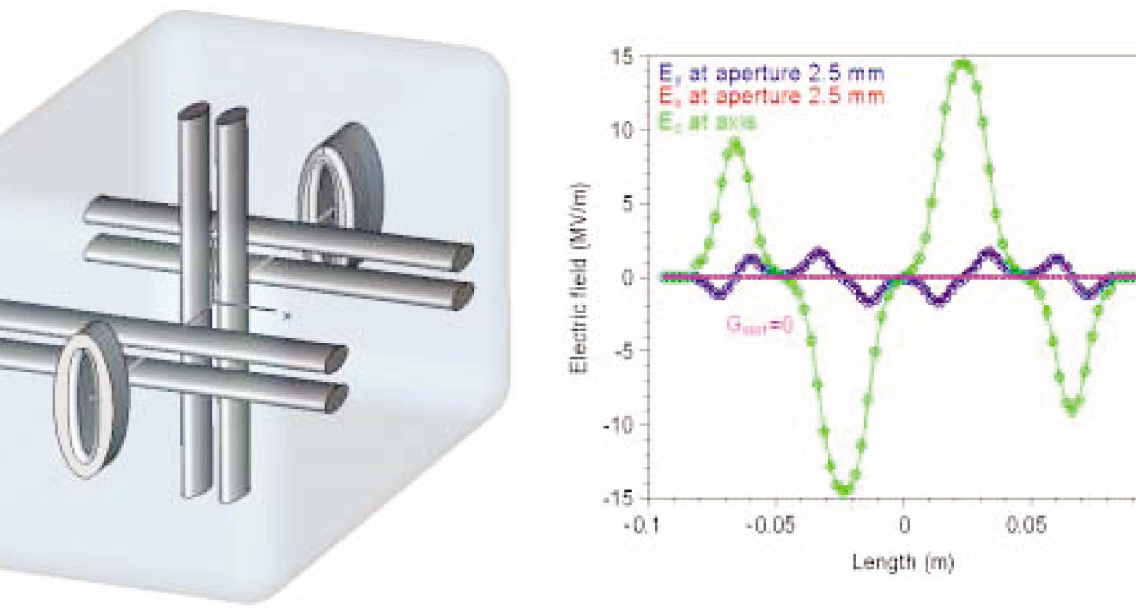
FIG. 5. (Color) E components in the spoke resonator for the x;y;z (cid:4) 40 MV = m energy W (cid:4) 3 MeV at E peak